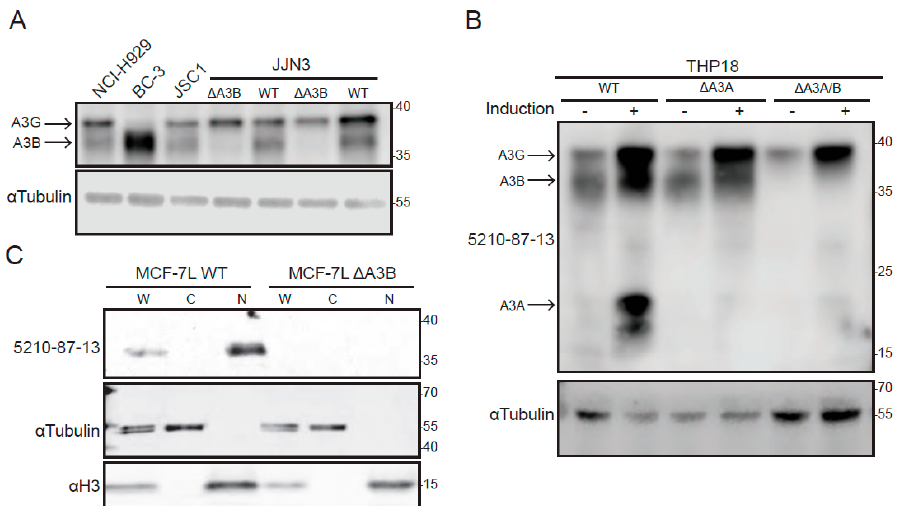
Figure 3. Endogenous A3B detection by 5210-87-13 mAb immunoblotting: ( A , B ) Immunoblots of whole cell lysates from the indicated cell lines probed with the 5210-87-13 mAb and anti-Tubulin as a loading control; and ( C ) immunoblots of whole-cell (W), cytoplasmic (C), and nuclear (N) fractions from the indicated cell lines probed with the 5210-87-13 mAb and with anti-Tubulin and anti-histone H3 as nuclear and cytoplasmic loading controls, respectively.